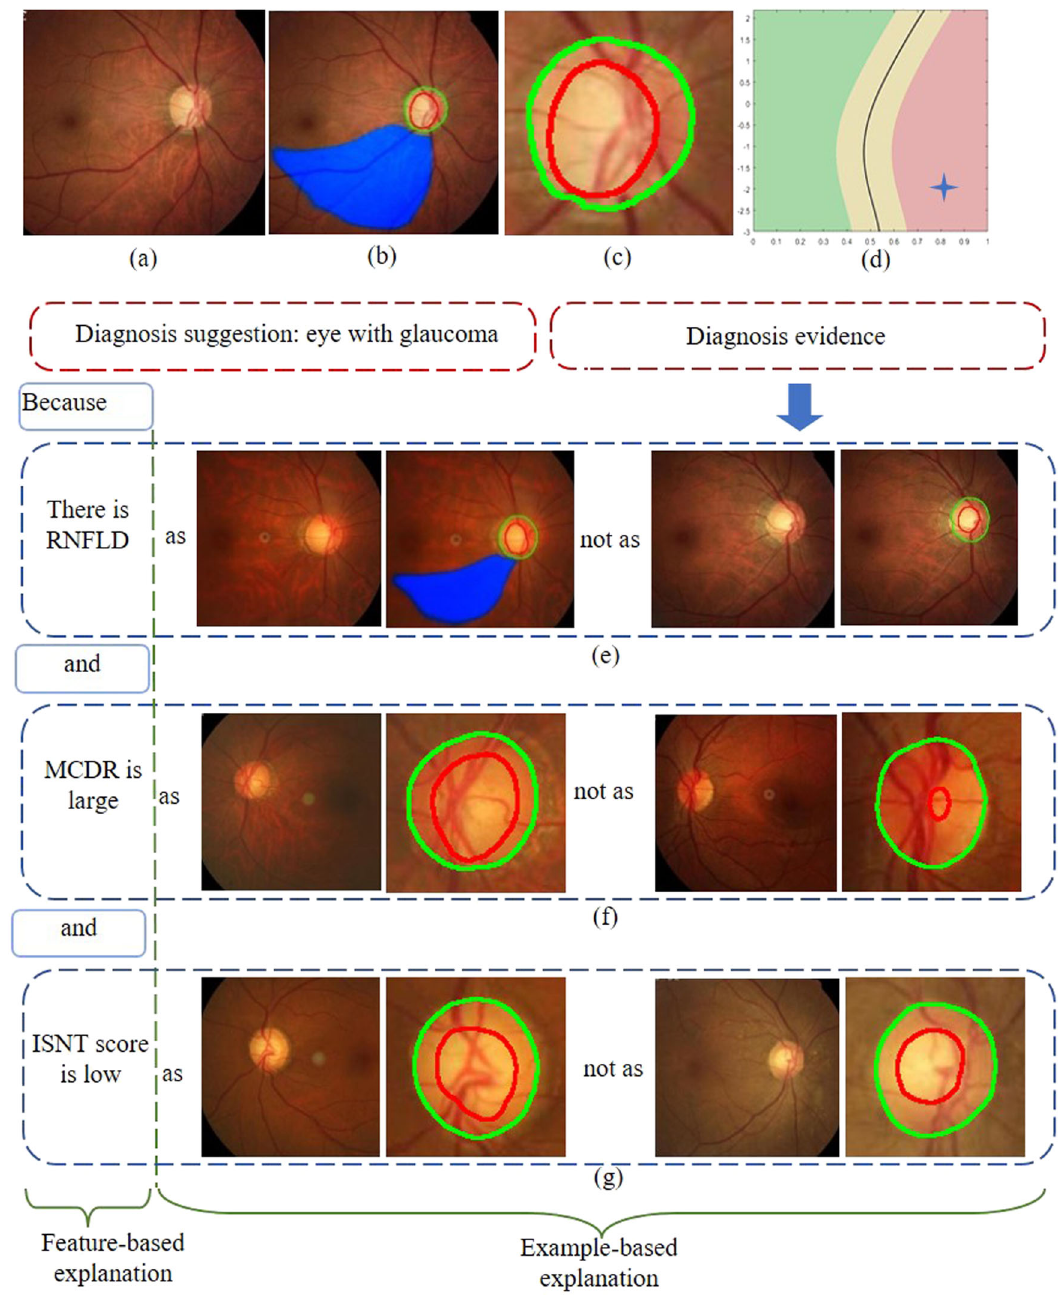
Fig. 2 Schematic of transparency and interpretability for hierarchical deep learning system. a Original fundus image. b Segmentation of OD, OC, and RNFLD. c Magni fi cation of the image shown in ( b ). d Two-dimensional plane of MCDR and ISNT score. e – g Comparison of the fundus image currently being evaluated with fundus images that have been clearly diagnosed in the database in terms of MCDR, ISNT score, and RNFLD. OD optic disc, OC optic cup, RNFLD retinal nerve fi ber layer defects, MCDR mean cup-to-disk ratio, ISNT inferior, superior, nasal,